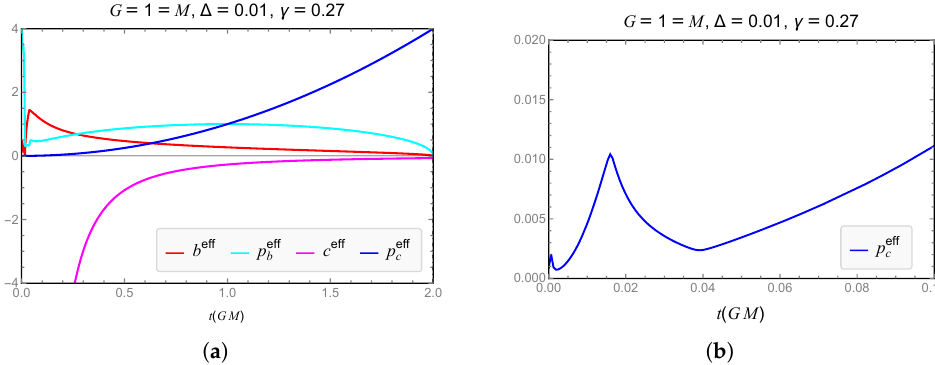
Figure 11. Solutions of the EoM of the ¯ µ case. ( a ) Solutions to the equations of motion in the ¯ µ (cid:48) case as a function of the Schwarzschild time t . ( b ) Close up of the left figure close to t = 0. Although p c behaves rather erratically close to t = 0, it never vanishes in this case